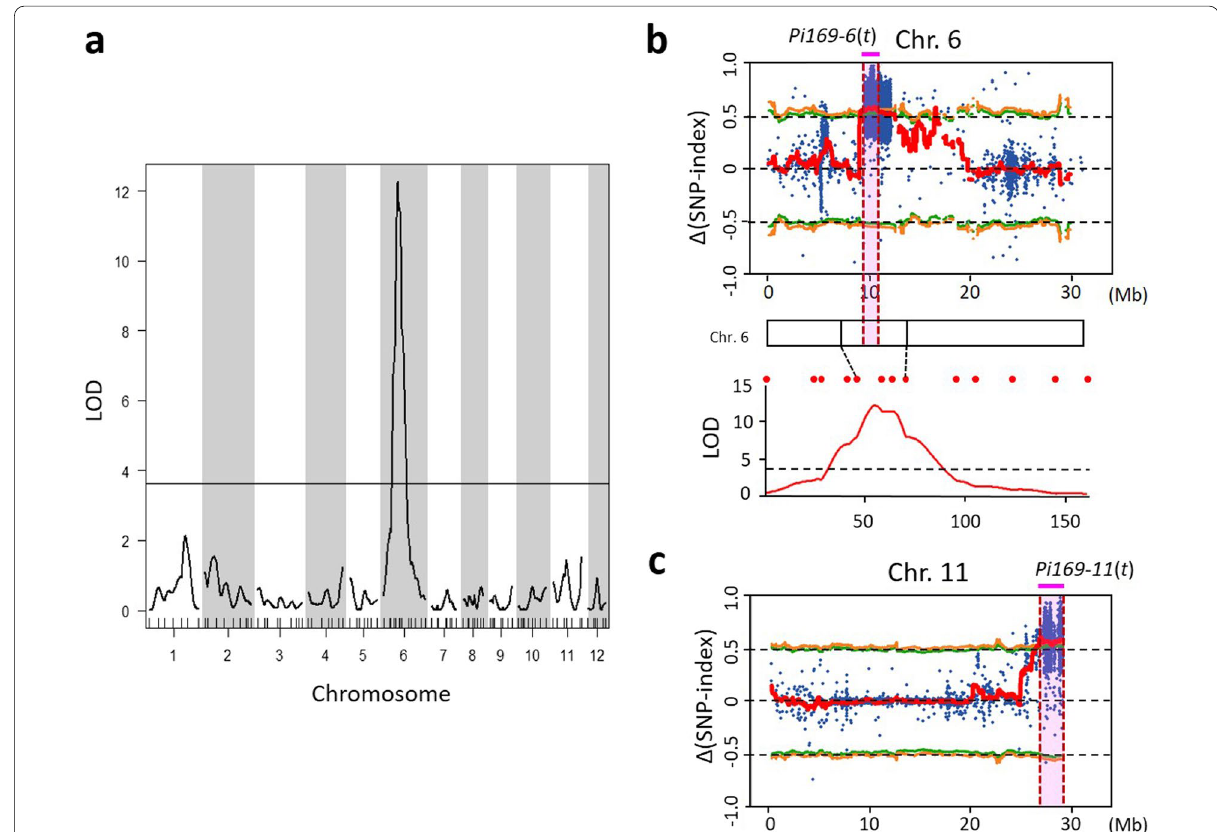
Fig. 1 Mapping of the blast resistance genes in SA0169 using linkage analysis and QTL‑seq. a Log of odds (LOD) plot by the Haley‑Knott regression method. Solid line indicates the LOD threshold of 3.64. b Δ(SNP ‐ index) plot of chromosome 6 with statistical confidence intervals under the null hypothesis of no QTLs (green lines, P < 0.05; orange lines, P < 0.01). Blue dots, ∆ SNP ‐ index. Red lines, the average Δ(SNP ‐ index) in a 1 Mb region using a 10 kb sliding window. Pink shaded region indicates the candidate region of blast resistance using the QTL‑seq strategy ( Pi169-6 ( t )). Bottom, LOD plot of blast resistance by linkage mapping. c Δ(SNP ‐ index) plot of chromosome 11. Pink shaded region indicates the candidate region of blast resistance ( Pi169-11 ( t